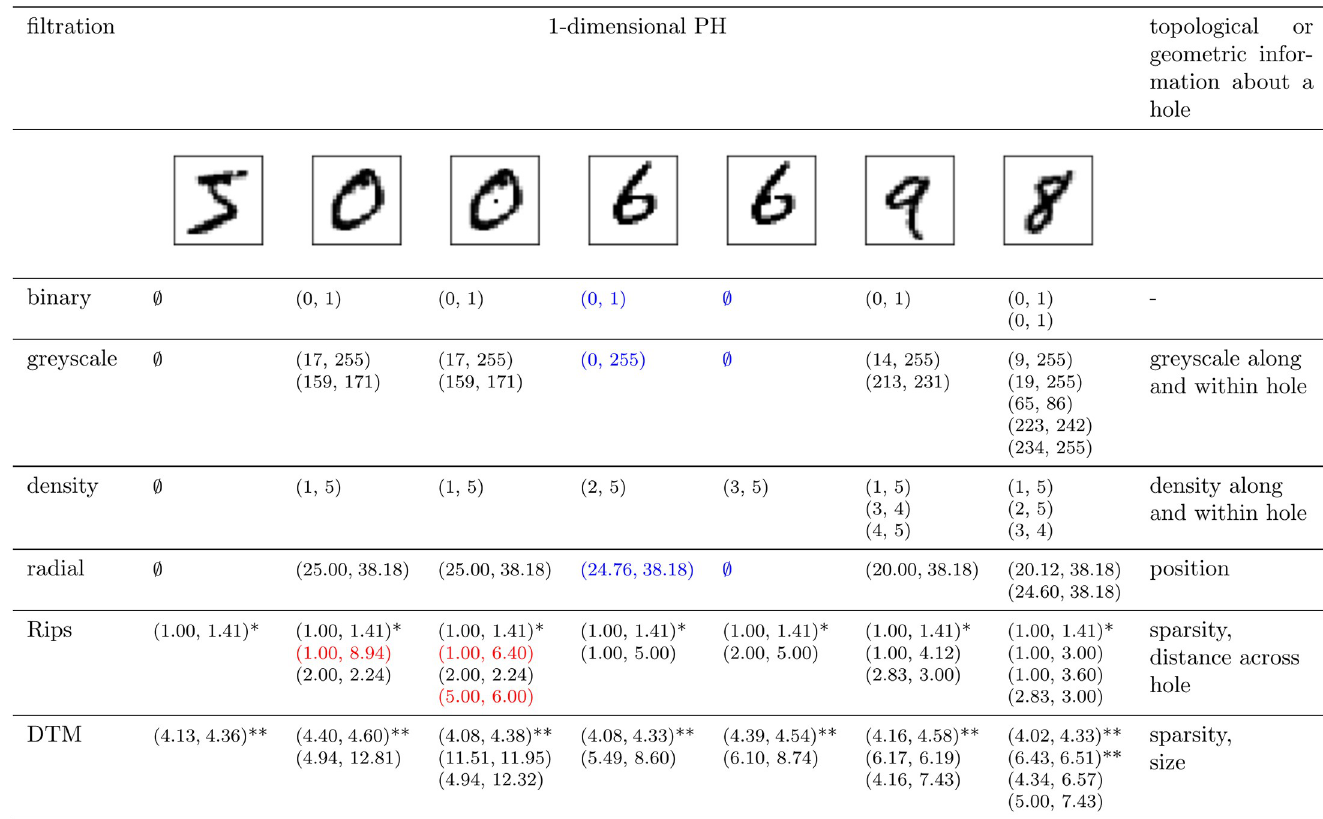
Fig 4. Persistent homology across filtrations. Persistent homology is a multi-set of persistence intervals ( b i , d i ), where b i and d i are respectively the time when a cycle i (a connected component, loop, void, etc.) is born, and when it dies in a filtration. The table lists 1-dimensional PH calculated for a few example MNIST images (or an image with an outlying pixel), across selected filtrations. The notation ( b , d ) � implies that multiple cycles appear and disappear at the same time (thus, PH is a multi -set, where each element has its multiplicity). The notation ( b , d ) �� implies that there are multiple intervals with a similar birth and death value. The cardinality of the set of persistence intervals determines the number of cycles. However, the definition of the filtration implies the interpretation of birth and death times, so that PH with different filtrations captures different topological (and geometric) information, what further influences its noise robustness and discriminating power. For example, an additional point at an outlying distance from a point cloud can have an important influence on PH with the Rips filtration (e.g., an additional black pixel within a hole will change the persistence of that hole, see persistence intervals in red), but this is less true for the DTM filtration, as the outlier will have a large distance from the nearest point cloud neighbours and will thus appear only very late in the filtration. A reverse example is a pixel with an outlying greyscale value (e.g., white pixel in a dark region) which has an important influence on PH with the binary, greyscale and radial filtration (in blue), but much less for the density, Rips and DTM filtration. If geometric information is captured, PH becomes sensitive under some affine transformations. Furthermore, 1-dimensional PH with binary, greyscale and density filtration cannot differentiate between digits 0, 6 and 9 (as they all have one hole of similar brightness), but radial filtration allows to discriminate between digits 6 and 9 (as the holes have a different position), and the Rips and DTM filtration enable to distinguish between 0 and 6 (as the holes are of different